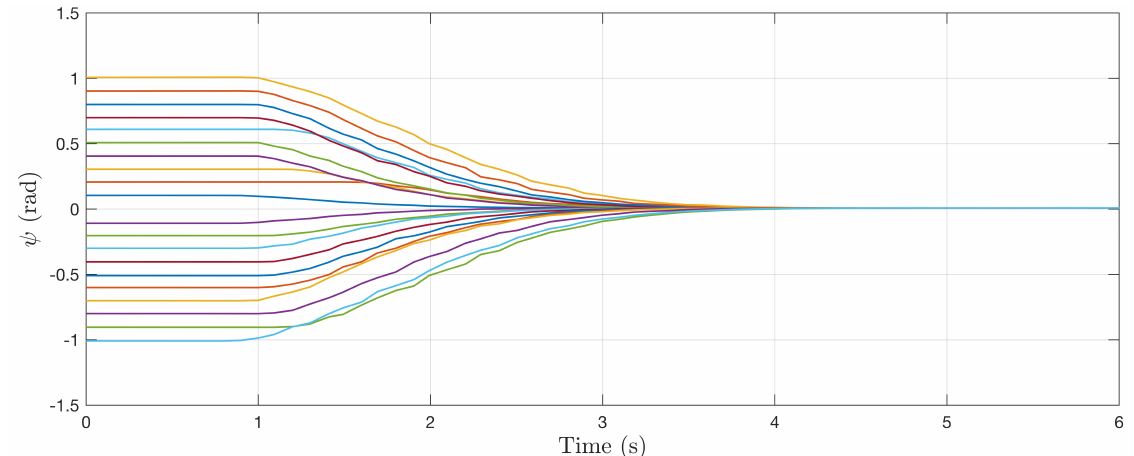
Figure 10. Collection of system responses to a nonzero initial vertical state. Each line represents a different trajectory with a unique nonzero initial perturbation to vertical position.